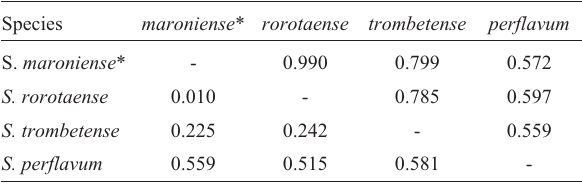
Table 3 - Matrix of similarity (above) and distance (below) in four species of the Simulium perflavum species group.